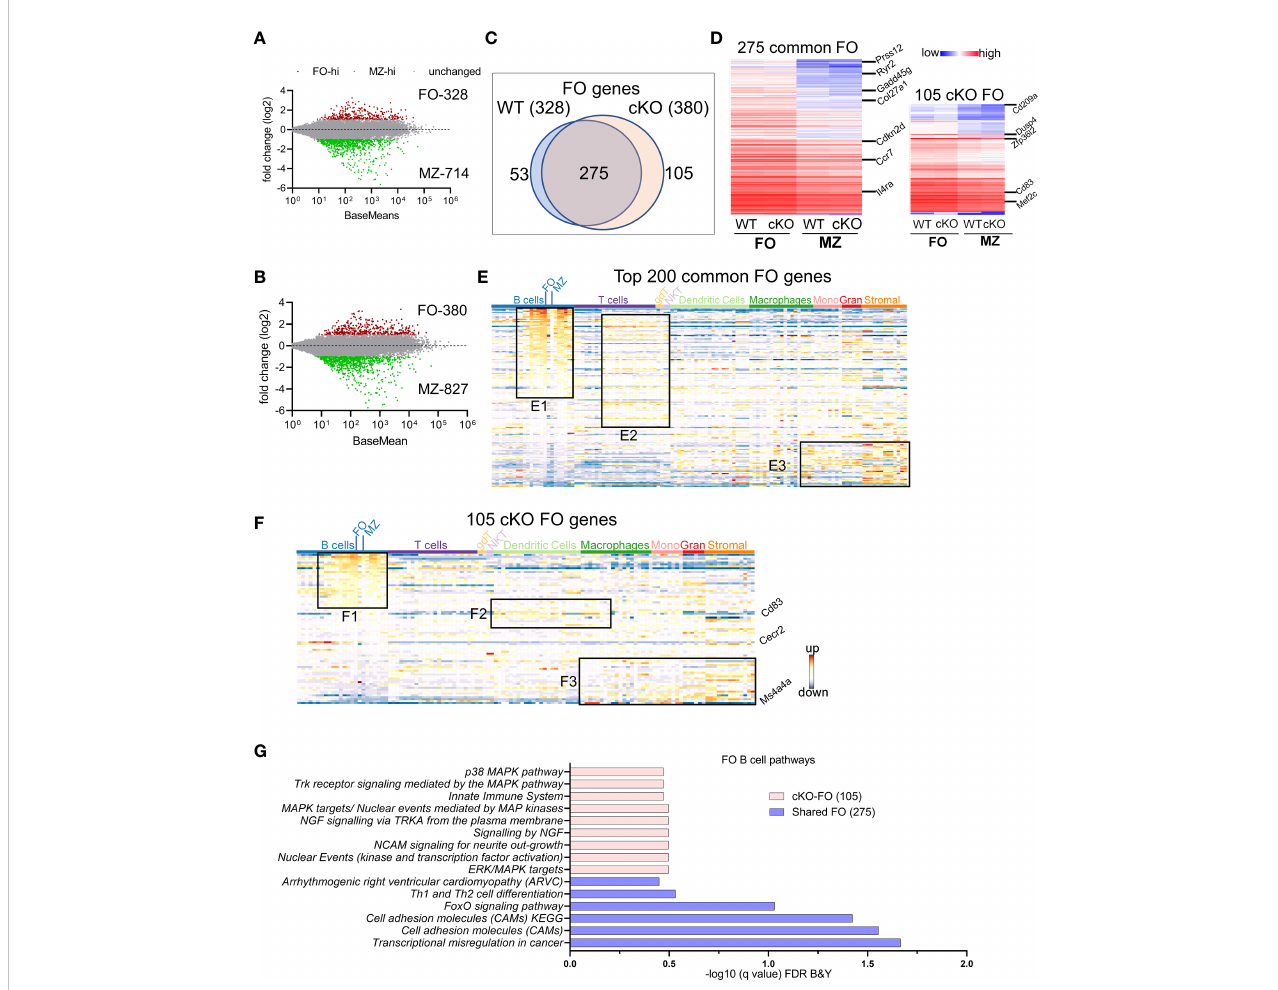
FIGURE 3 FO andMZ Bcell de fi ningtranscriptome inWTandcKOmice. TotalRNAwasextractedfromFO andMZ BcellsofWTandcKO mice.TheRNAwas usedforbar- codedlibrarypreparations andsequencing. (A,B) MAplotdisplayingthe logfold-changecomparedwithmeanexpression andshowingthe differentially expressed genes (DEGs)inFO andMZBcells of theWT (A) andof thecKO (B) mice. (C) Venndiagramshowingthe genes thatarecommonversestheonesuniquetoFO B cellsbetweentheWTandthe cKO mice. (D) Heatmapdemonstratingaverage counts(CPM, n=2)normalized by DESeq2 of the275FOcommongenes(left panel) and of the105uniquecKO genes(rightpanel). (E) 200commonFOgeneswerequeriedagainstthe ImmGen-Database toidentify theirenrichment in thedifferent immunecell populations. Heatmap representingtheexpression of thesegenesinallimmunecells.GenesenrichedintheBcellcompartmentsareshowninboxE1, genes enrichedinTcellscompartments are showninE2 andgenesenrichedinmonocytes, granulocytes andstromal cellsareshowninE3. (F) 105cKO FO speci fi c genes werequeriedagainsttheImmGen-Database asinE andthegenesenrichedinBcell compartmentsareshownin box F1, genesenrichedintheDendriticand Macrophagecellsare showninbox F2 whilegenesthatareenrichedinthemyeloid and stromallineagesareshowninboxF3. (G) Gene Ontologies(GO)analysis usingToppGenesuite, theanalysiswas carriedoutusingeithertheshared(sharedbetweenWTandcKO)FOorthecKO speci fi cFOBcell